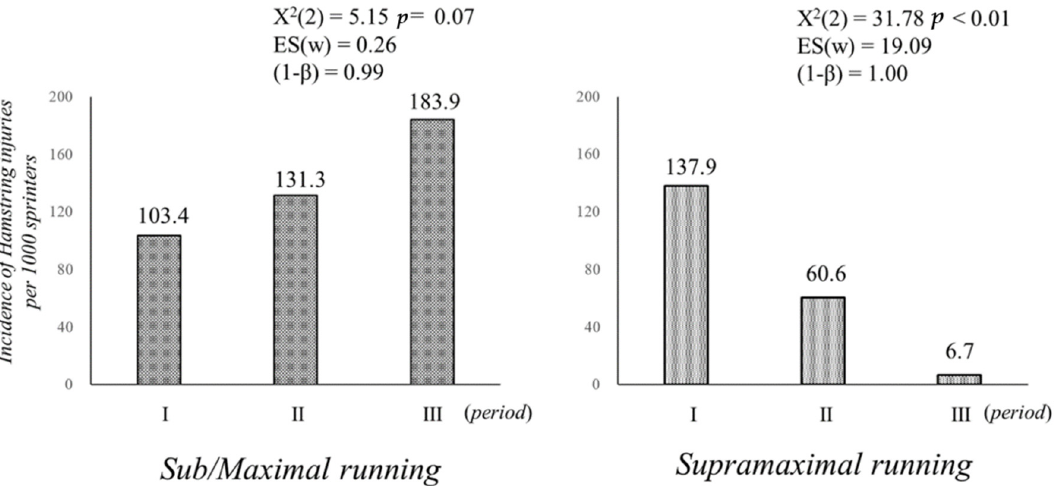
Figure 4. Hamstring injury rate during submaximal, maximal, and supramaximal running.